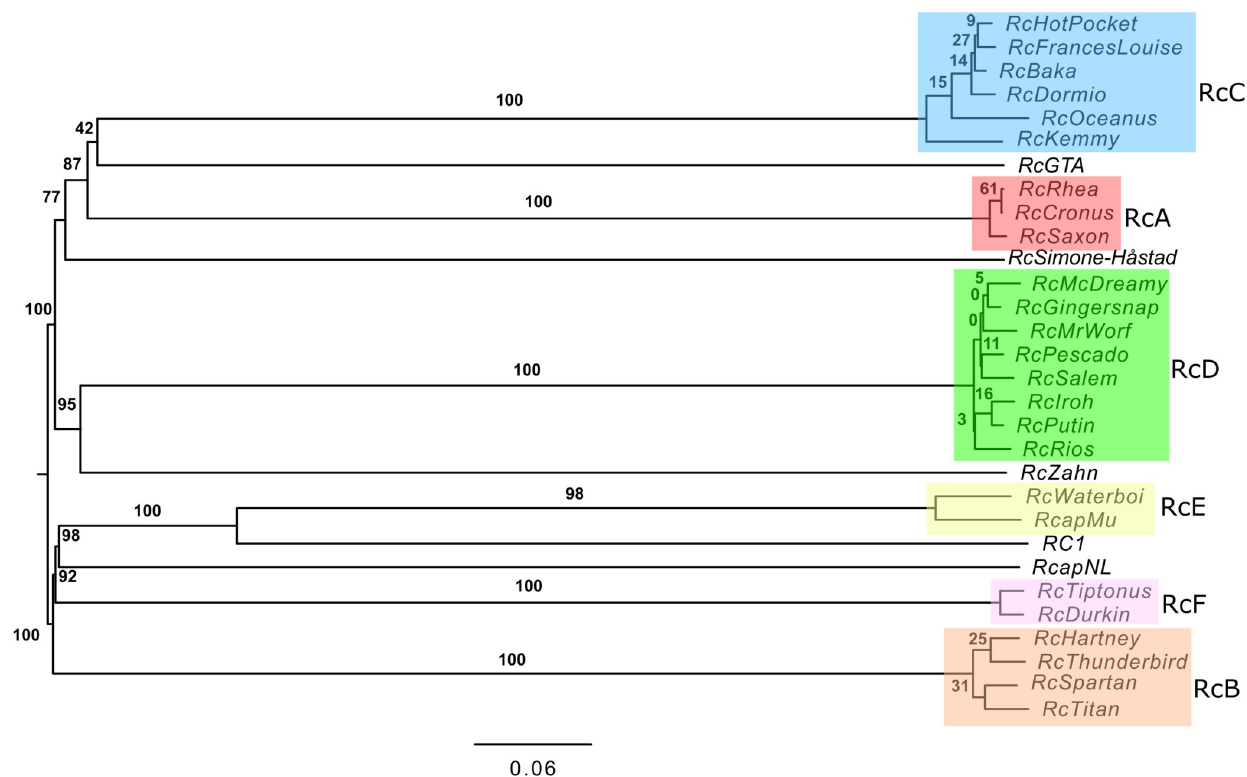
Fig 4. Evolutionary relationships of R . capsulatus bacteriophages and RcGTA. The genome BLAST distance phylogeny (GBDP) tree generated using phage nucleotide sequences entered into the VICTOR web application under settings recommended for prokaryotic viruses and the D0 distance formula. The numbers above branches are GBDP pseudo-bootstrap support values from 100 replications. The branch lengths on the resulting VICTOR tree are scaled in terms of the respective distance formula used.